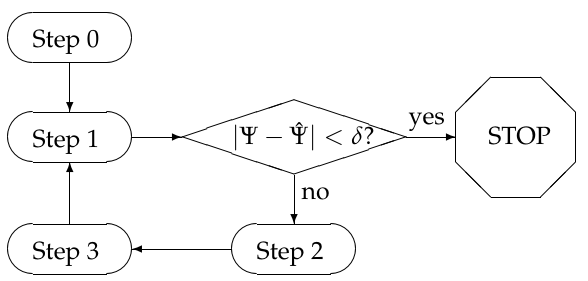
Figure 2. Diagram of the algorithm for scenario selection.